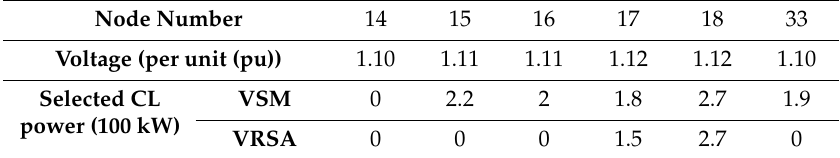
Table 3. Voltage and selected CL powers. VSM—voltage sensitivity method; VRSA—voltage ranking search algorithm.